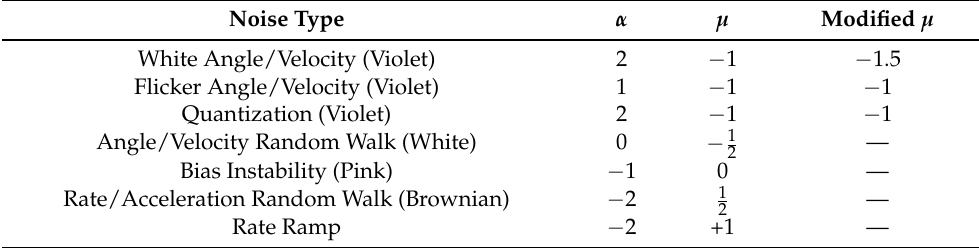
Table 1. Noise types corresponding to the logarithmic slope of the power spectral density, α , and the logarithmic slope of Allan deviation as a function of averaging time, µ [35,36,38]. Noise Type α µ Modified µ White Angle/Velocity (Violet) 2 − 1 − 1.5 Flicker Angle/Velocity (Violet) 1 − 1 − 1 Quantization (Violet) 2 − 1 − 1 Angle/Velocity Random Walk (White) 0 − 1 — 2 Bias Instability (Pink) − 1 Rate/Acceleration Random Walk (Brownian) − 2 Rate